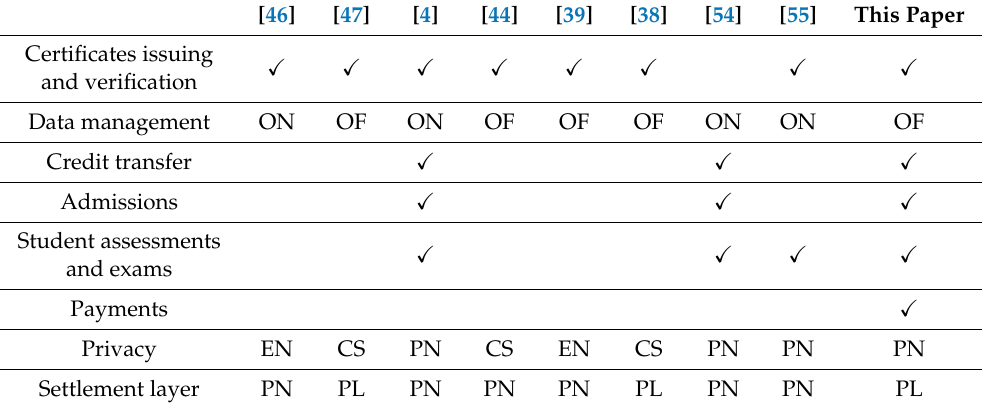
Table 6. Comparison with the mentioned